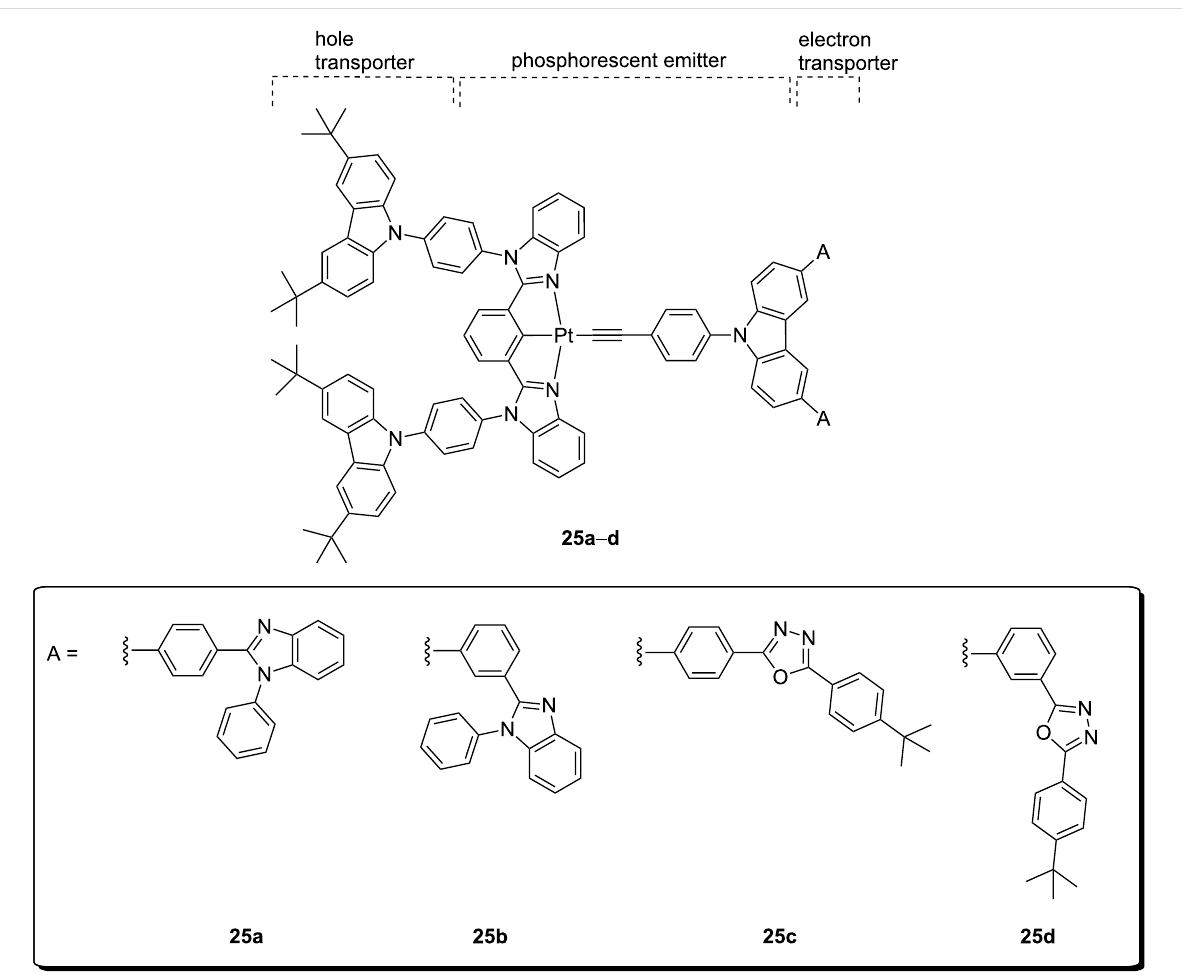
Figure 13: Molecular structure of bipolar alkynyl-platinum(II) complexes 25 bearing carbazole and electron-accepting phenylbenzimidazole or oxadia- zole moities